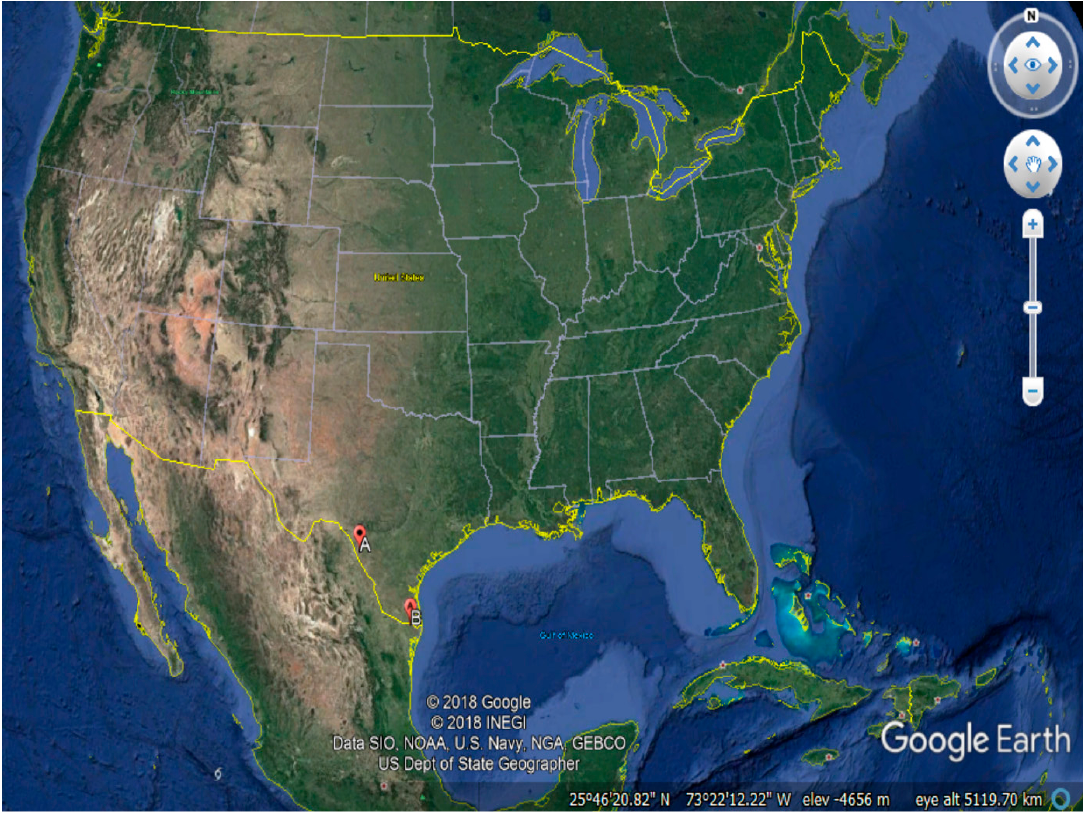
Figure 2. Wind sites in the Southern District of Texas.